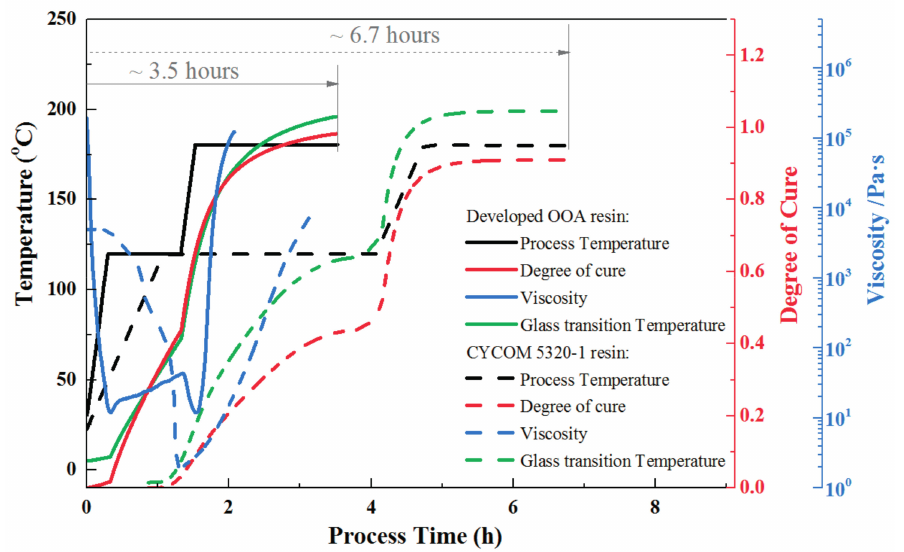
Figure 14. Manufacturing time saving of rapidly cured out-of-autoclave laminates compared with traditional out-of-autoclave